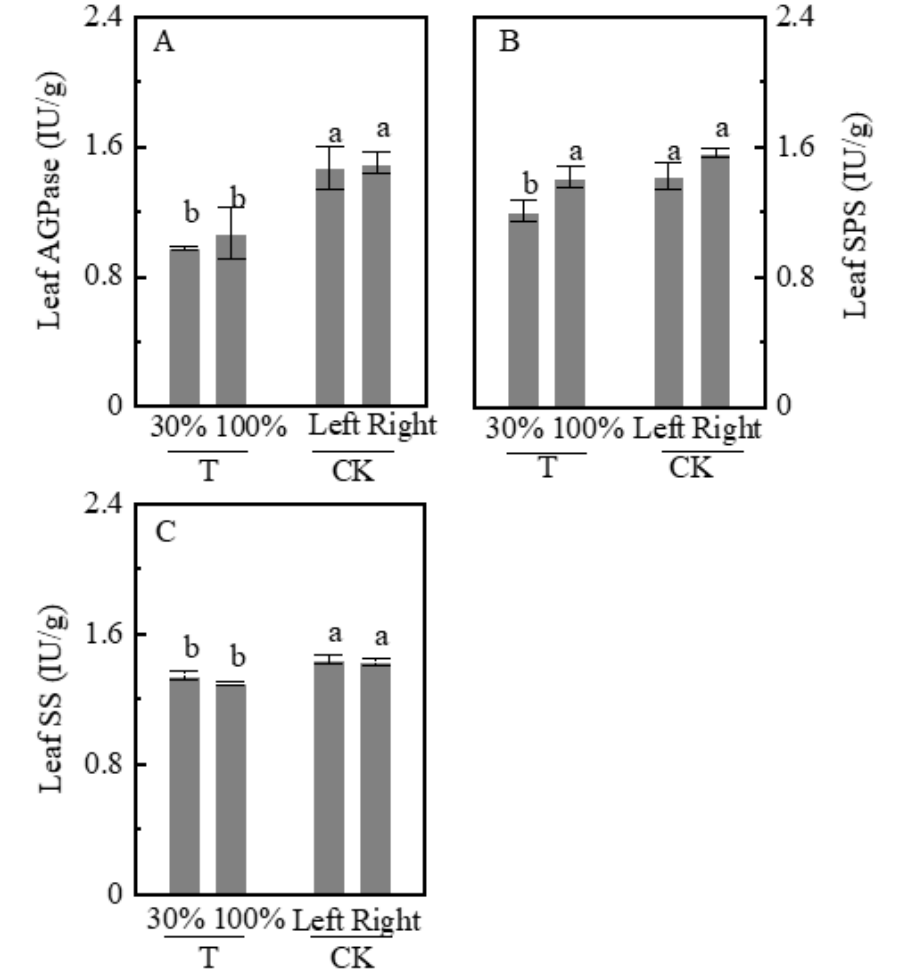
Figure 5. Activitieskeyenzymesinsucroseandstarchsynthesisinleaves.( A ):ADP-glucosepyrophosphorylase (AGPase); ( B ): sucrose phosphate synthase (SPS); ( C ): sucrose synthase (SS); IU, 1 IU is the amount of enzyme that catalyzes the reaction of 1 µ mol of substrate per minute. Data are averages of three replicates and bars represent standard errors. Plants grown under heterogeneous light (T), the left side leaves were under shade (T-30%) and right side leaf under natural light (T-100%). All leaves were under full sunlight (CK). Data with different letters are significantly different ( p <